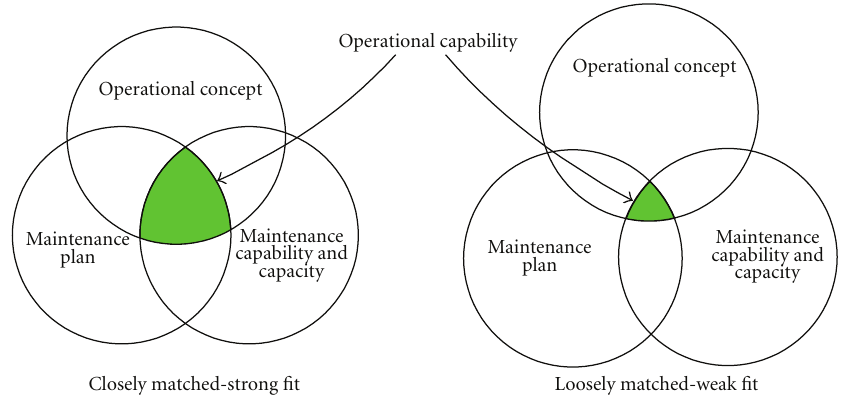
Figure 1: Interactions that a ff ect operational